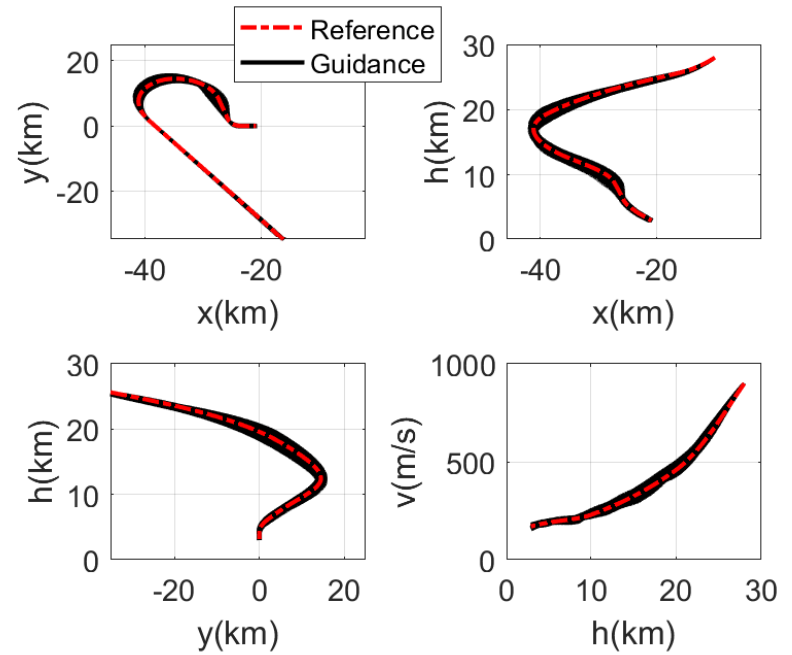
Figure 4. Three views of the TAEM trajectories and the velocity profiles with respect to altitude in Monte Carlo